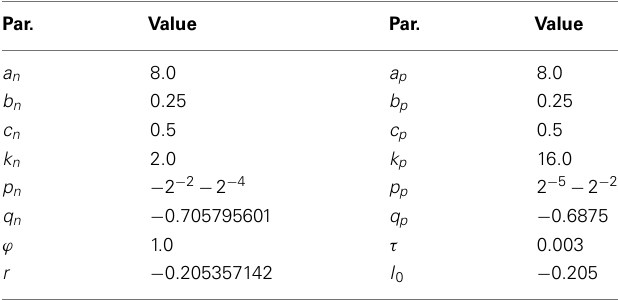
Table 1 | Parameters for Class I mode.